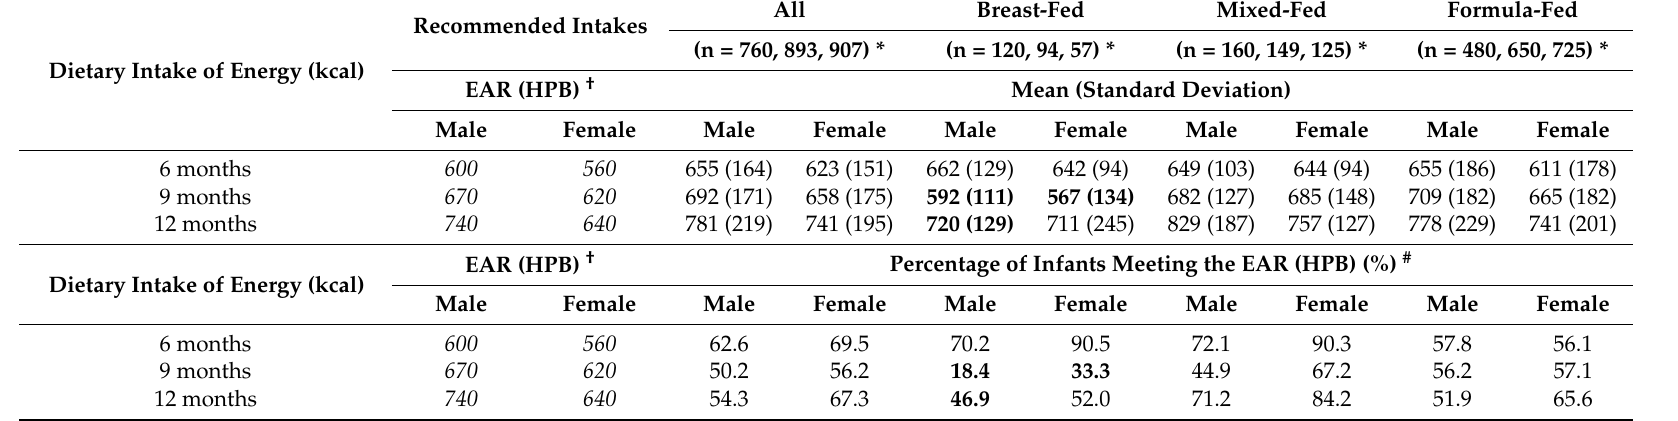
Table 3. Cross sectional analyses of energy, by gender, of all infants and stratified by type of milk feed. All Breast-Fed Mixed-Fed Recommended Intakes Dietary Intake of Energy (kcal)